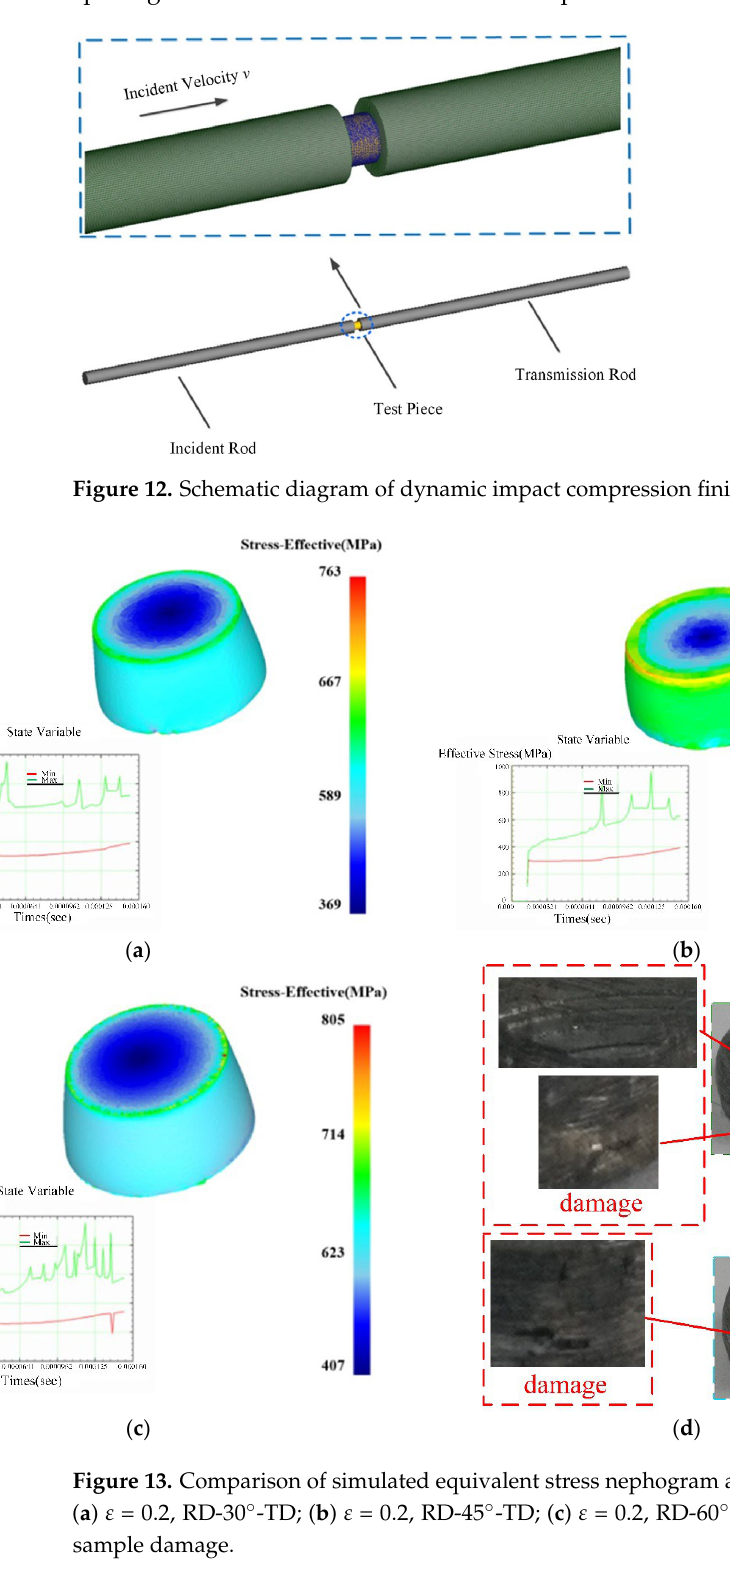
Figure 11. Stress–strain prediction curves under different loading conditions, ( a ) Predicted stress– strain curve at a strain rate of 0.2 × 10 4 s − 1 . ( b ) Predicted stress–strain curves of the 45° specimens at different temperatures .